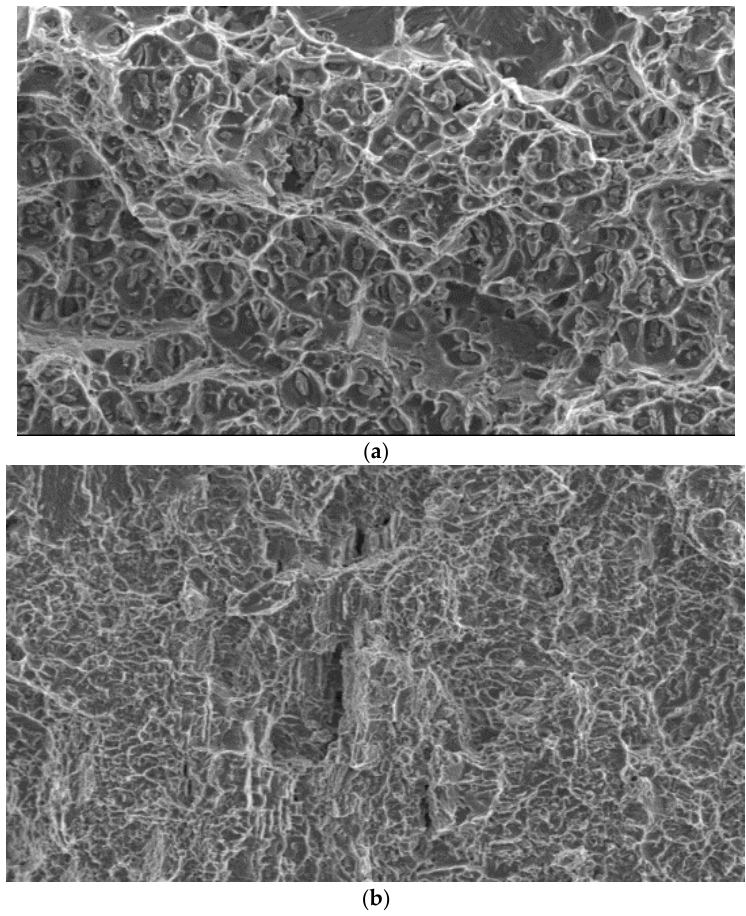
Figure 7. Fracture mechanism in the base materials. ( a ) Al alloy (AA2519); ( b ) Ti alloy (Ti6Al4V).